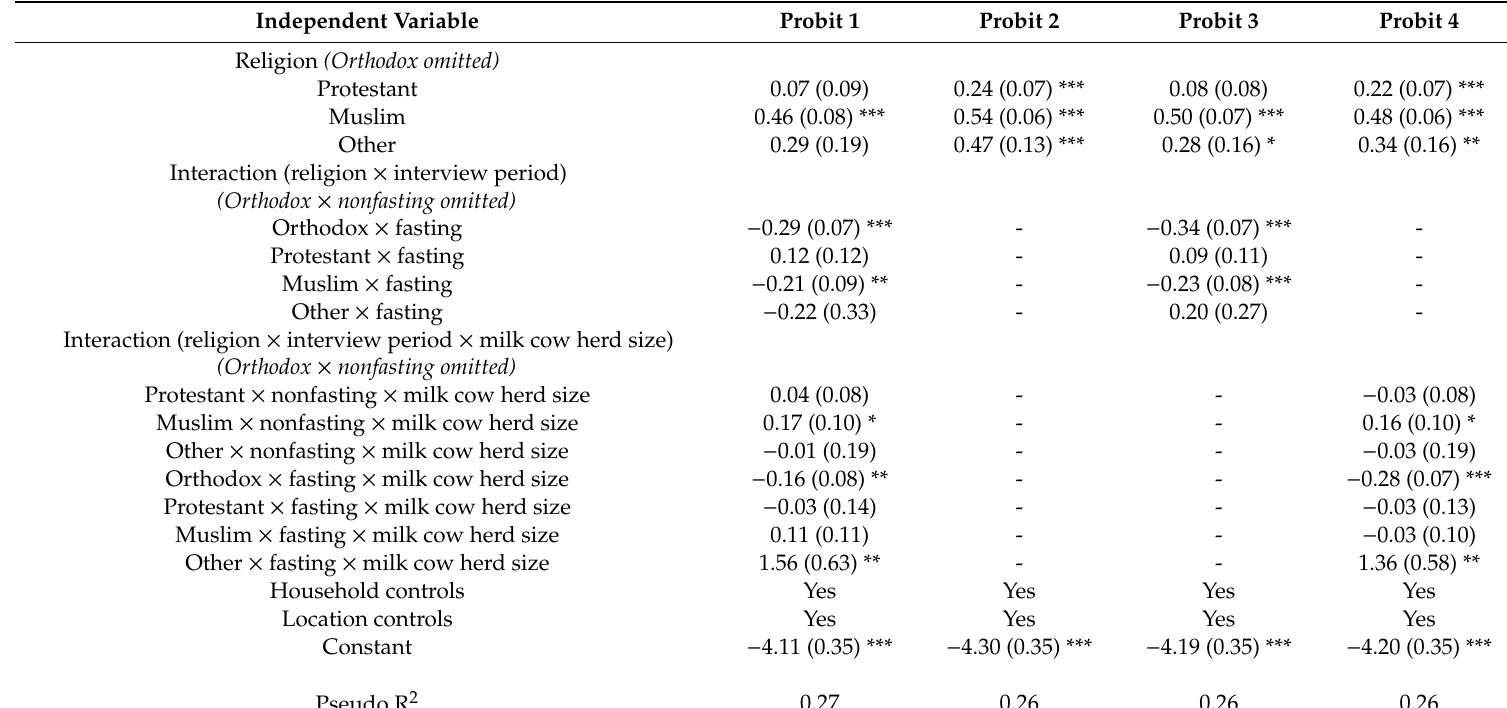
Table 2. Results from Probit